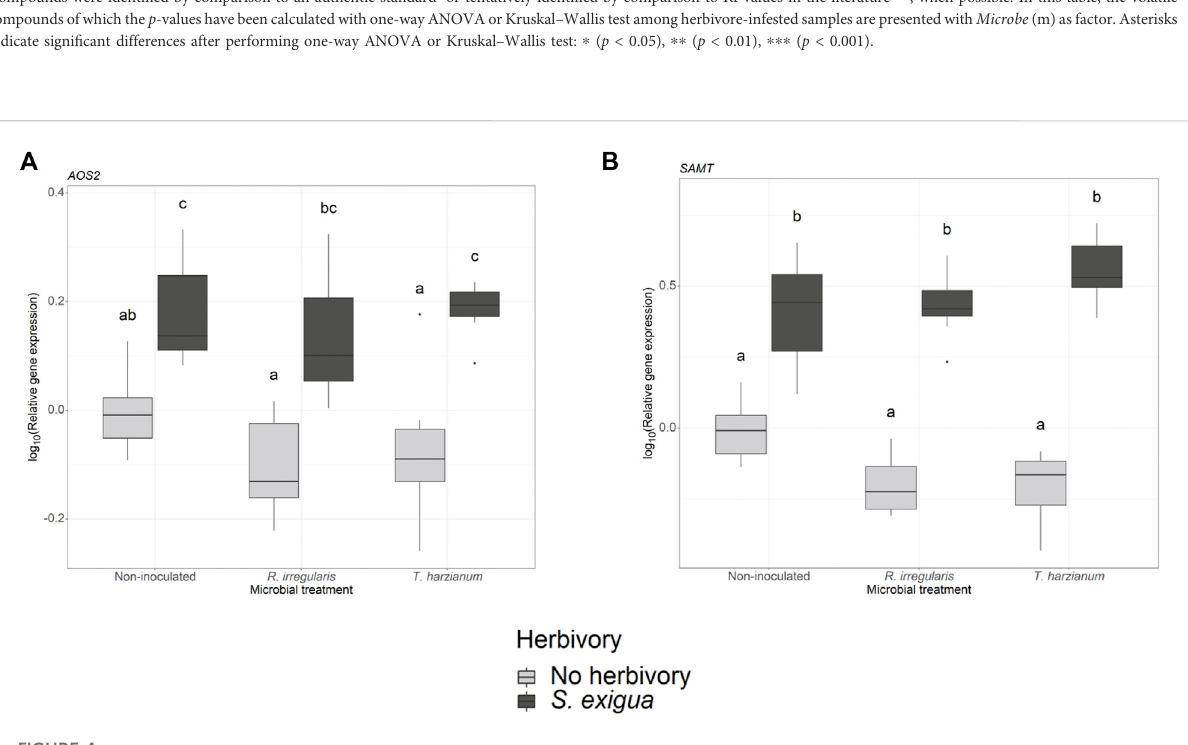
FIGURE 4 Transcript levels of two defense-related genes in non-inoculated and root-inoculated tomato plants non-infested or infested by Spodoptera exigua larvae for 24 h. Panel (A) depicts the transcript levels of the gene allene oxide synthase 2 (AOS2), and panel (B) depicts the transcript levels of thegenesalicylicacidmethyltransferase(SAMT).Thegenesdepictedwereselectedbasedontheeffectof S.exigua herbivory,orbene fi cialmicrobes on their transcript levels. Values are the average of the three technical replicates for each of six-seven biological replicates per treatment. Expression levels for the selected genes were normalized to the mean of tomato elongation factor 1a gene expression levels in each sample as reference.Lightgray-colored boxplotsrepresentnon-herbivore-infestedplantsanddark gray-colored boxplotsrepresent S.exigua -infestedplants. Signi fi cant differences between treatments are indicated by different letters after Tukey ’ s post hoc tests after two-way ANOVA: p <